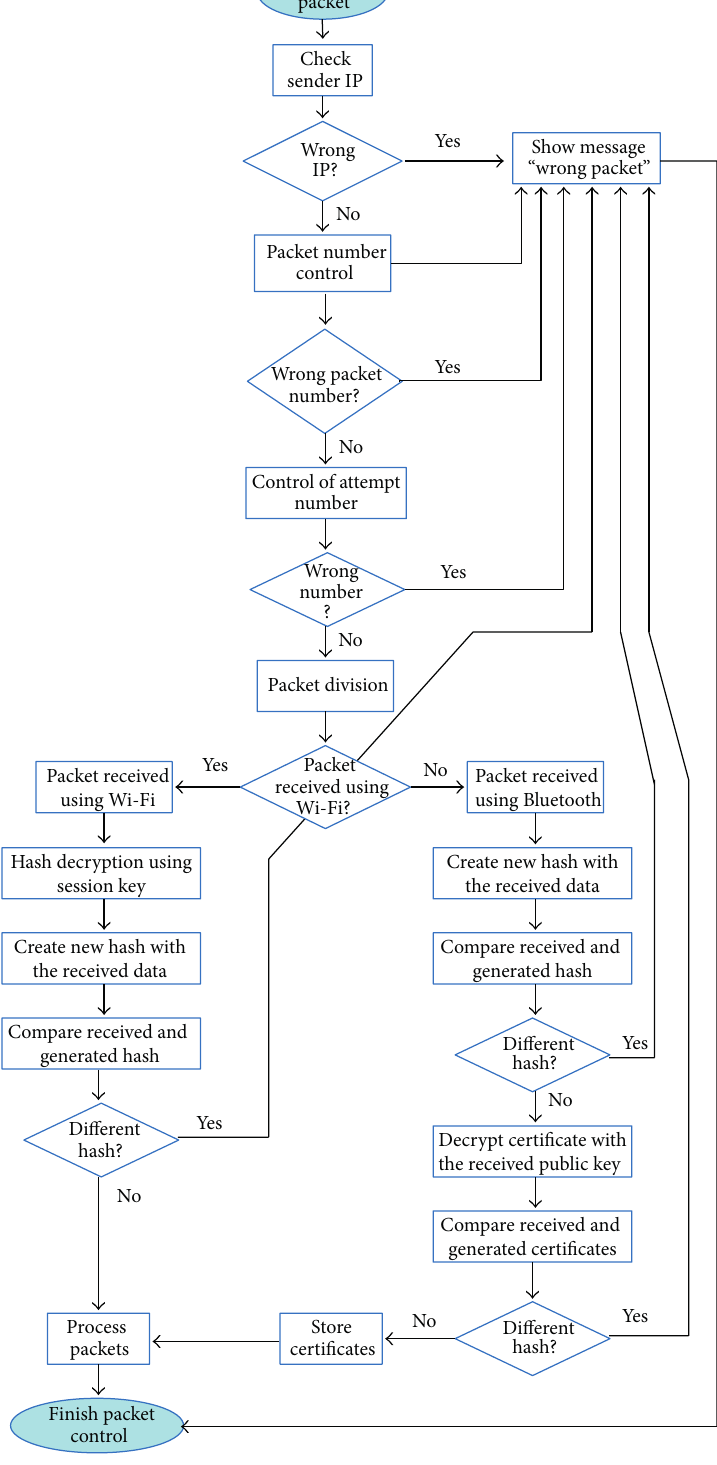
Figure 4: Packet